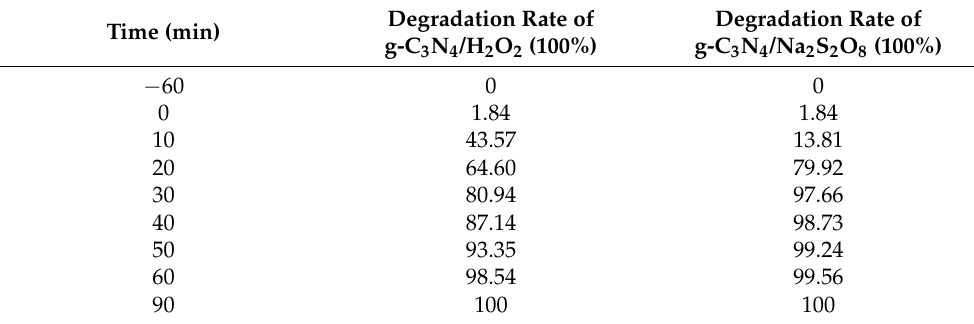
Table 1. Degradation rate of Rhb in synergistic systems.